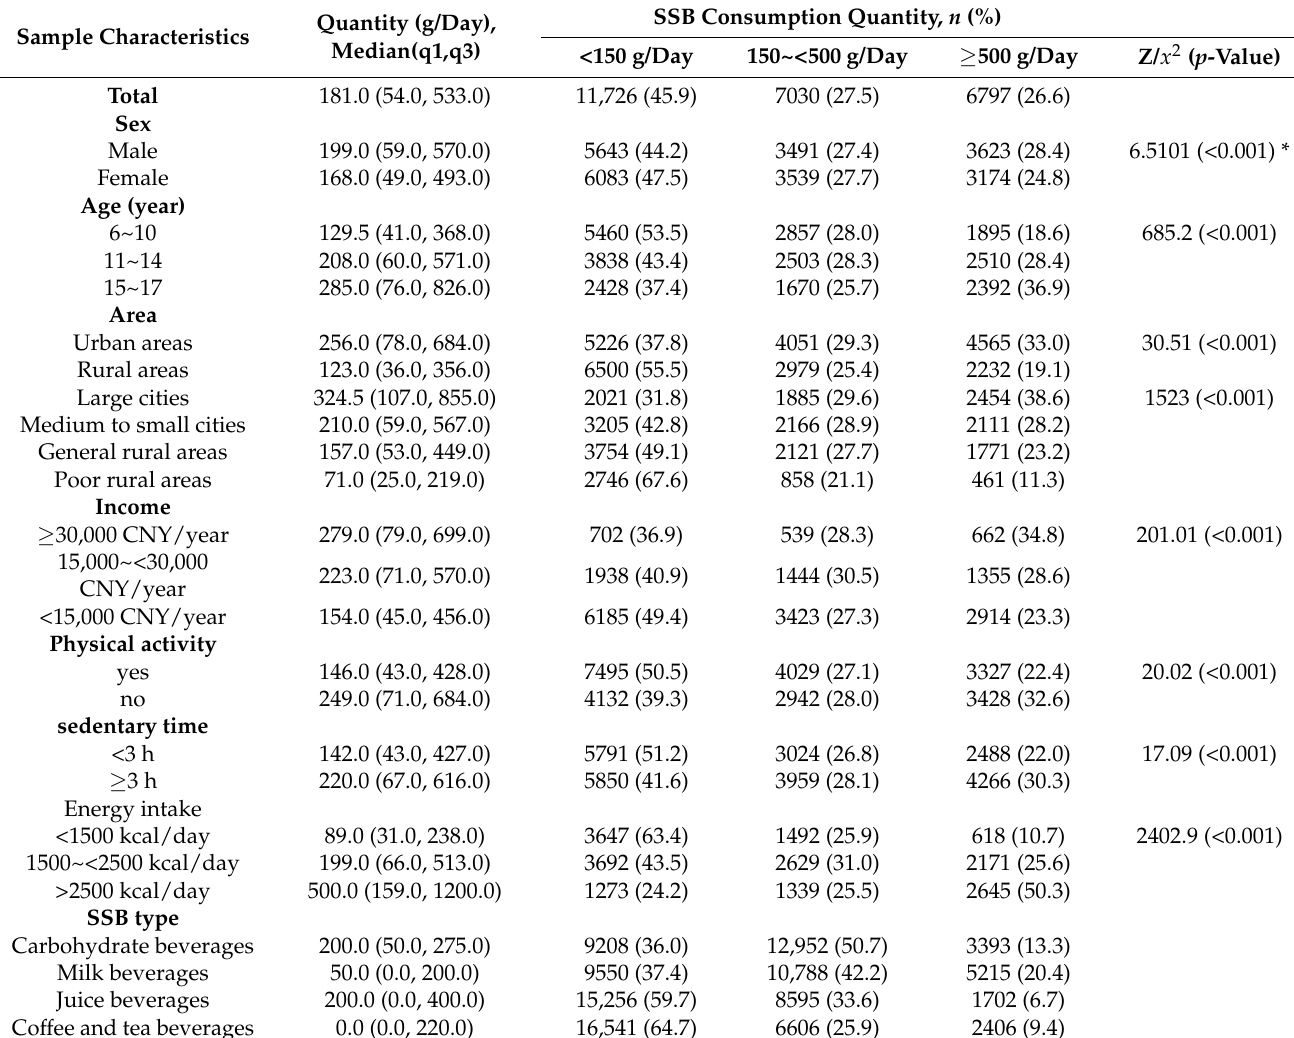
Table 3. Quantities of SSB consumption among Chinese 6–17-year-old children in 2012 ( n =